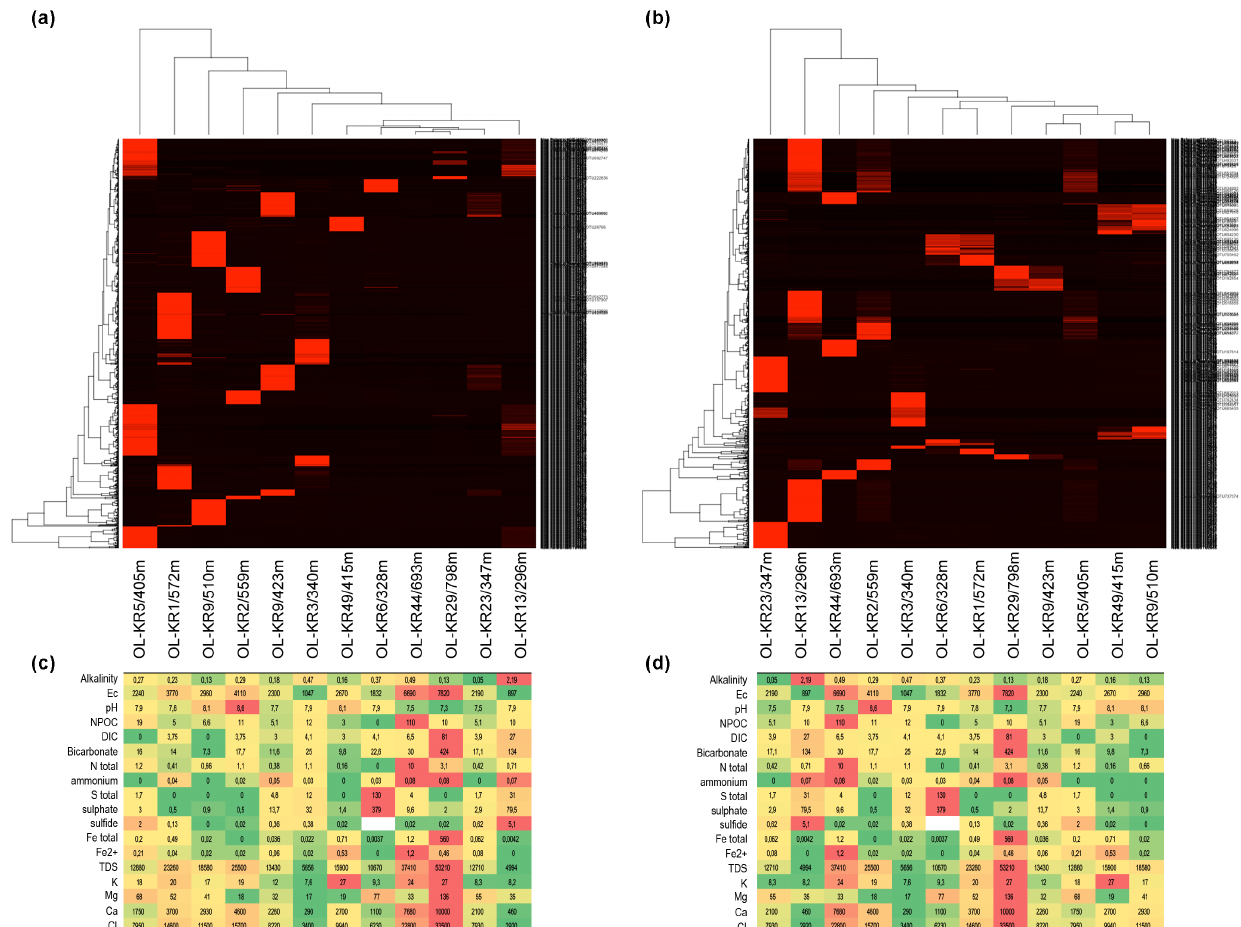
Figure 5. A UPGMA cladogram clustering the samples based on the 1000 biggest OTUs of the (a) archaeal and (b) bacterial OTU profile according to the Bray–Curtis distance model. Black indicates low abundance and red colour indicates high abundance. (c) and (d) show the corresponding physicochemical parameters as shown in Table 1, with the lowest values in green, medium values in yellow, and high values in